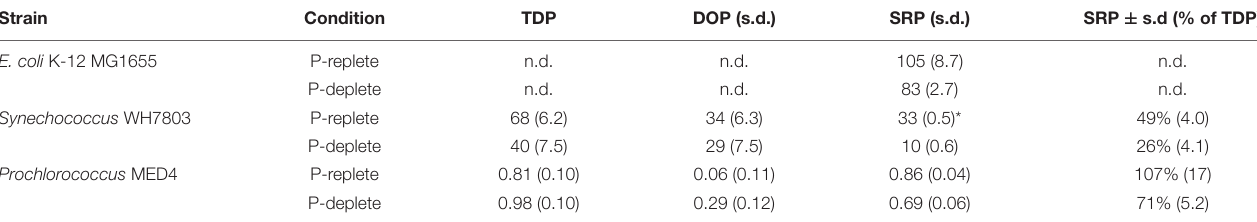
TABLE 1 | Initial phosphorus release upon cell lysis, in amol/cell.